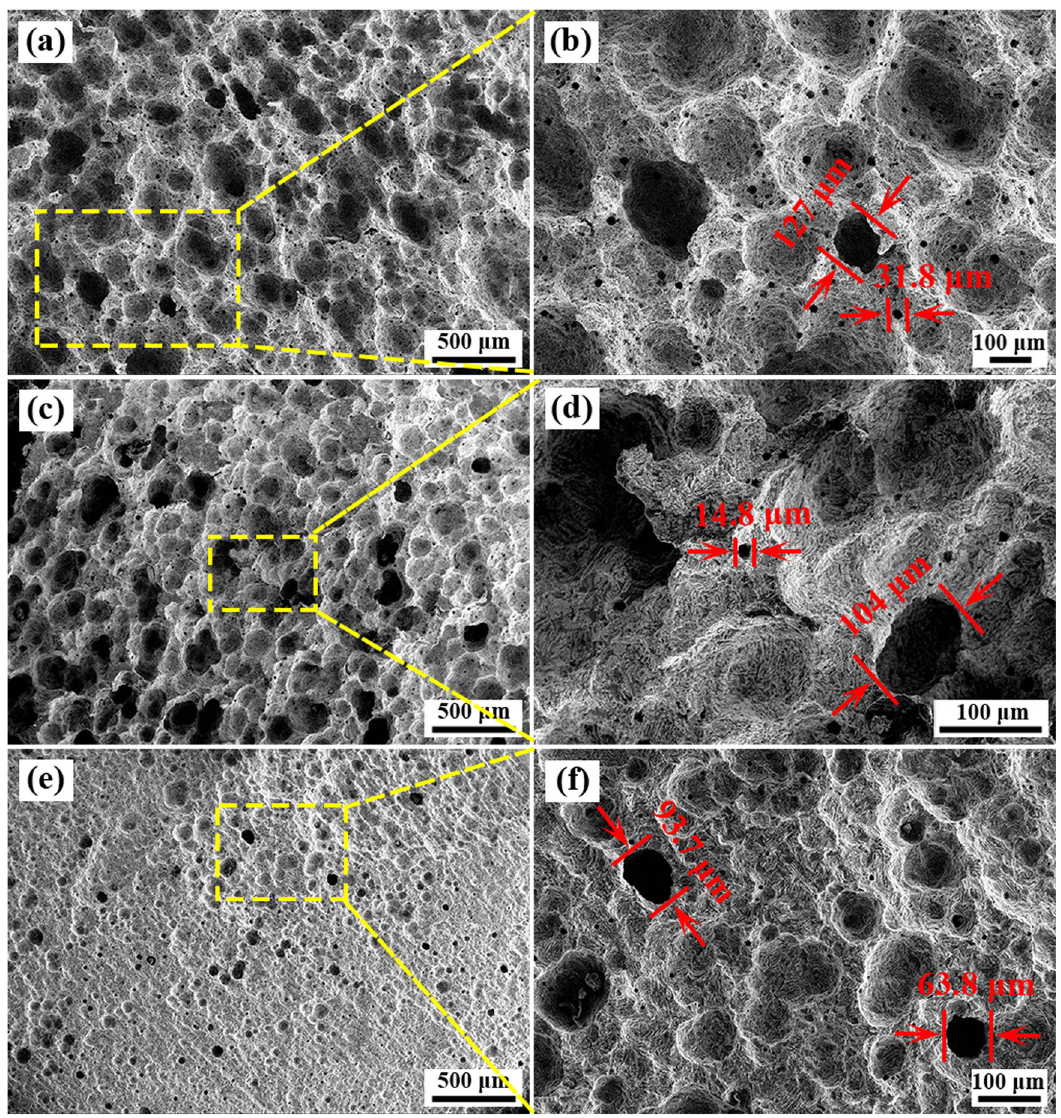
Fig. 1 SEM images of the coupons after exposure to the tidal zone. Corrosion morphologies of the matrix for the AISI 4135 steel coupons after exposure to the a , b HTL, c , d MTL and e , f LTL for 3